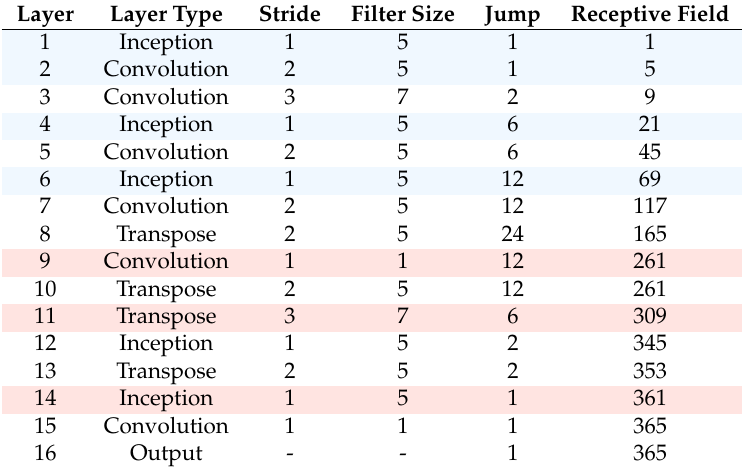
Table 1. Layer-by-layer calculation of receptive field through the network. This follows the encoder and decoder displayed in Figure 1. The jump reaches its maximum before the first transpose convolution, where it then begins to decrease. Blue rows indicate that their outputs are sent through a residual connection, whilst red rows indicate the operation has a residual connection to its input. Layer Layer Type Stride Filter Size Jump Receptive Field